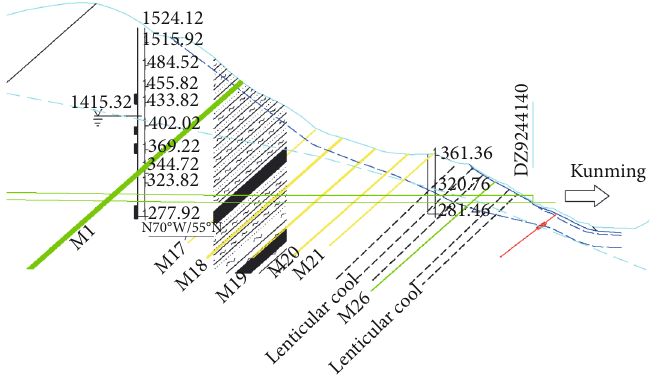
Figure 1: Pro fi le of the Liujiazhuang tunnel.